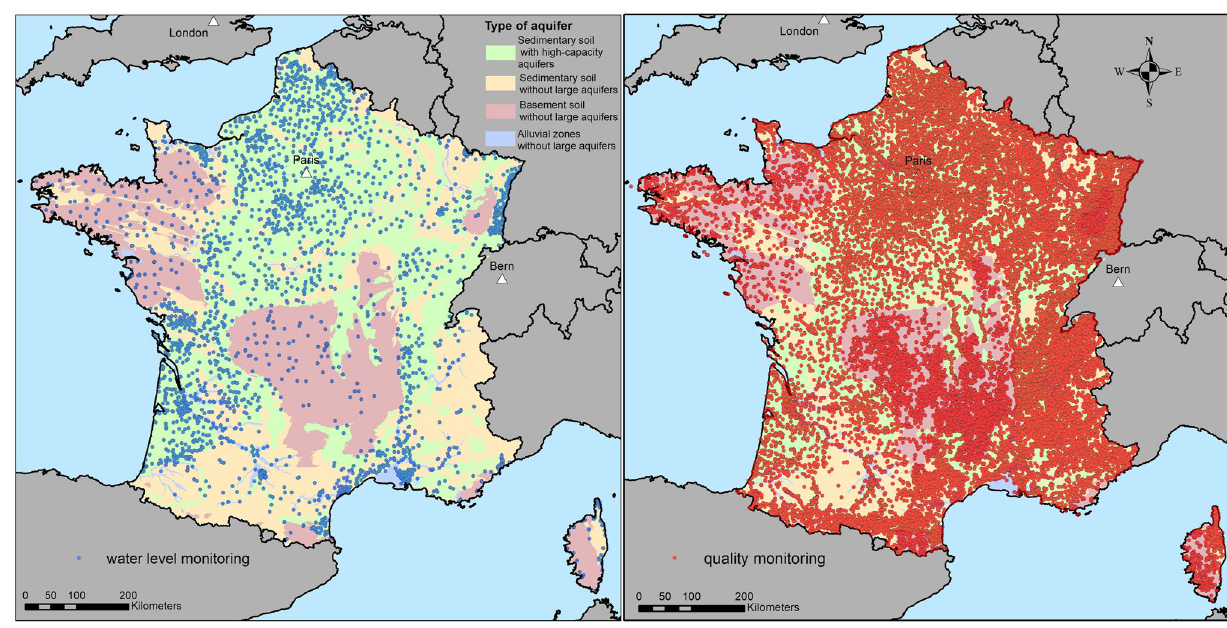
Fig. 2 Map of monitoring stations available in ADES, not including BRGM observation wells (wells outside monitoring